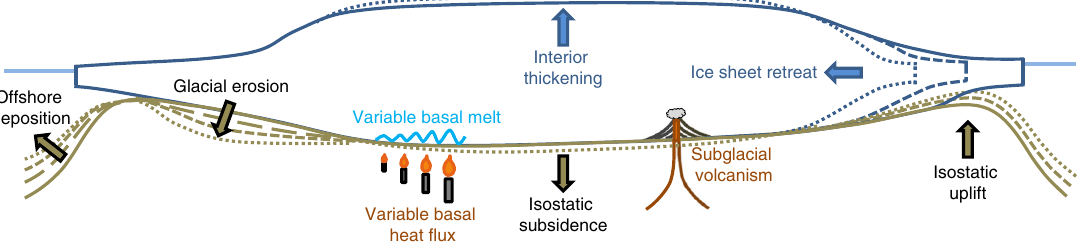
Fig. 1 Summary of interactions between the solid Earth and the Antarctic Ice Sheet. Local isostatic uplift occurs in response to ice-sheet thinning or retreat, isostatic subsidence occurs in response to ice-sheet thickening or advance. Subglacial volcanism and basal heat fl ux alter thermal conditions at the base of the ice sheet. Erosion and deposition also trigger an isostatic response (not shown). Increasing time indicated by fi ner